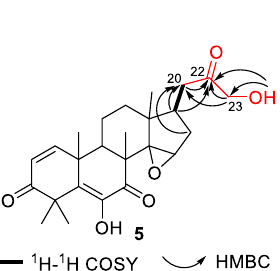
C) correlations of →